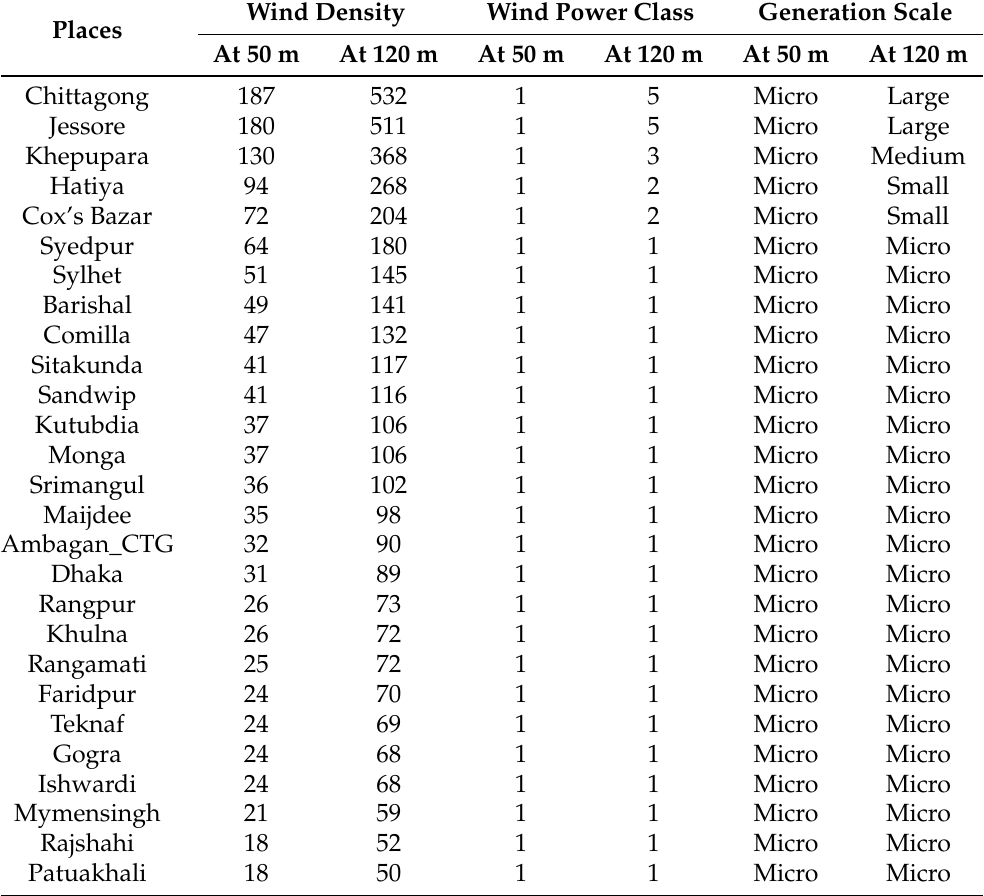
Table 6. Wind energy potential in Bangladesh